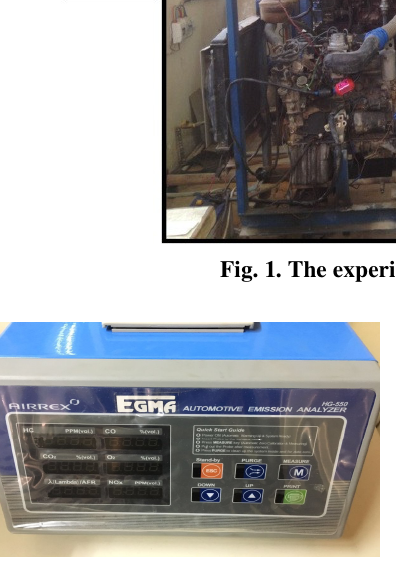
Fig. 2. The gas analyzer type HG-550 used in the tests .